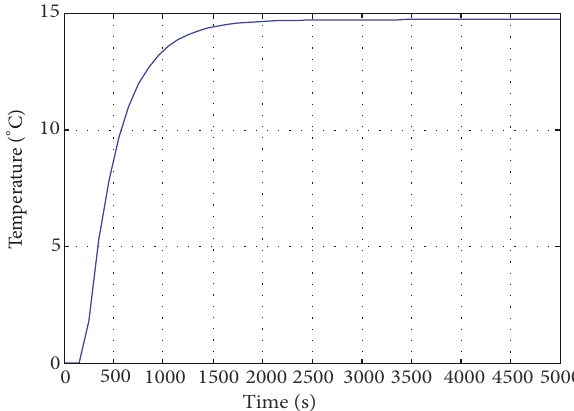
Figure 5: The variation curve of 𝑦 1 when the load of generator unit is 500MW, 𝑢 𝑗 ∈ [0,12] , and the increment of 𝑢 2 is 4.